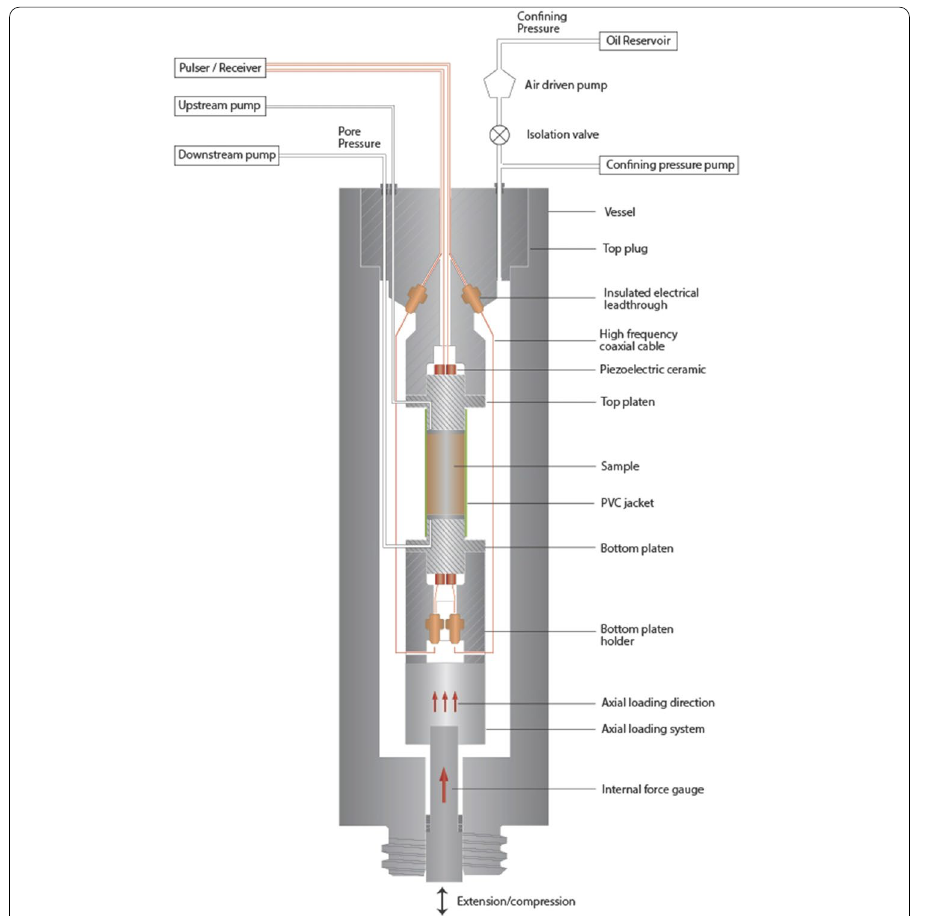
Fig. 2 A schematic illustration of the sample assembly contained within the pressure vessel used for the experiments described. It also highlights the position of the piezoelectric crystals within the assembly that are used for the P- and S-wave velocity measurements (Faulkner and Armitage